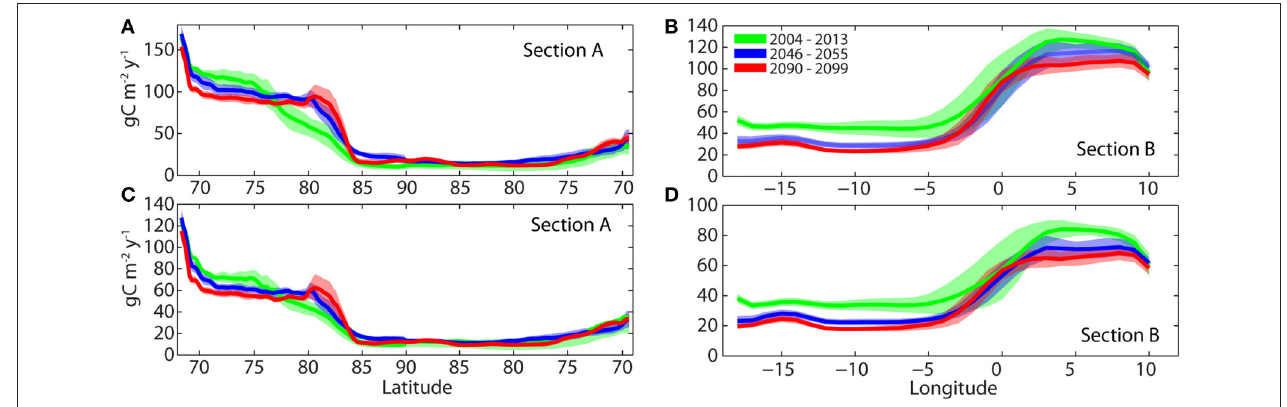
FIGURE 13 | Annual simulated gross primary production (GPP, upper panel), new production (NP, lower panel) along transect A (A,C) and transect B (B,D) (Figure 2) for the period 2001–2010 (green), the period 2046–2055 (blue) and the period 2090–2099 (red). The shaded areas correspond to the period mean values are ± one standard